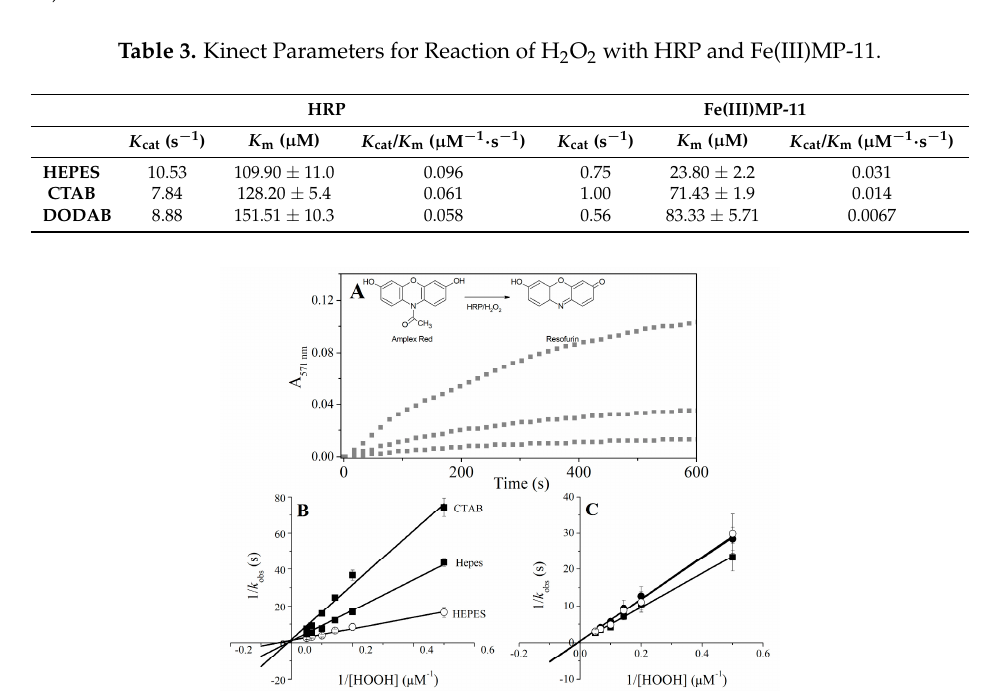
Figure 7. Kinetic study of the reaction of Fe(III)MP-11 and HRP with Amplex Red ® as a function of hydrogen peroxide concentration. ( A ) Representative curves of resofurin production during the Amplex Red ® oxidation by Fe(III)MP-11 associated with CTAB micelles, using 2, 5 and 10 µM of hydrogen peroxide; ( B ) Fe(III)MP-11 and ( C ) HRP Lineweaver-Burk plots of the reciprocal k obs values obtained by fitting the curves of temporal generation of resofurin vs. the reciprocal of the hydrogen peroxide concentration. The inset of panel A shows the structures of Amplex Red ® and resofurin. Experimental conditions were: 100 nM Fe(III)MP-11 or 25 nM HRP, hydrogen peroxide concentrations were used in the range of 2–20 µM and 40 µM Amplex Red ® buffered by HEPES. The reactions were carried out in a homogeneous medium (solid squares), 20 mM CTAB (solid circles) and 2 mM DODAB (open circles).